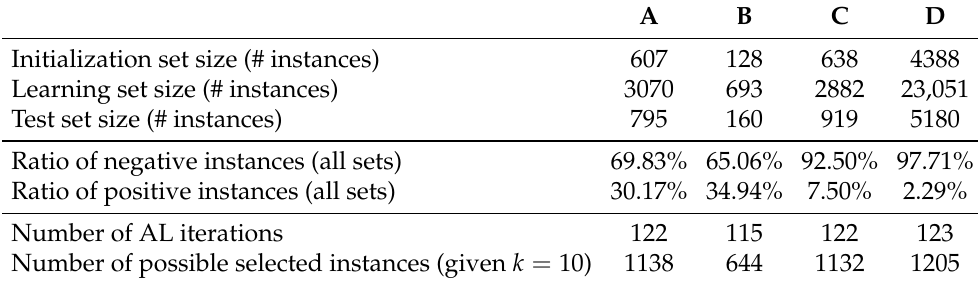
Table 3. Overview of the active learning datasets with total number of instances per each split, ratio of negative and positive instances, as labeled by the human annotators, number of iterations on the learning set when AL is used and maximum number of possible queried instances by limiting the budget with k = 10 instances per iteration. “# instances” denotes “the number of